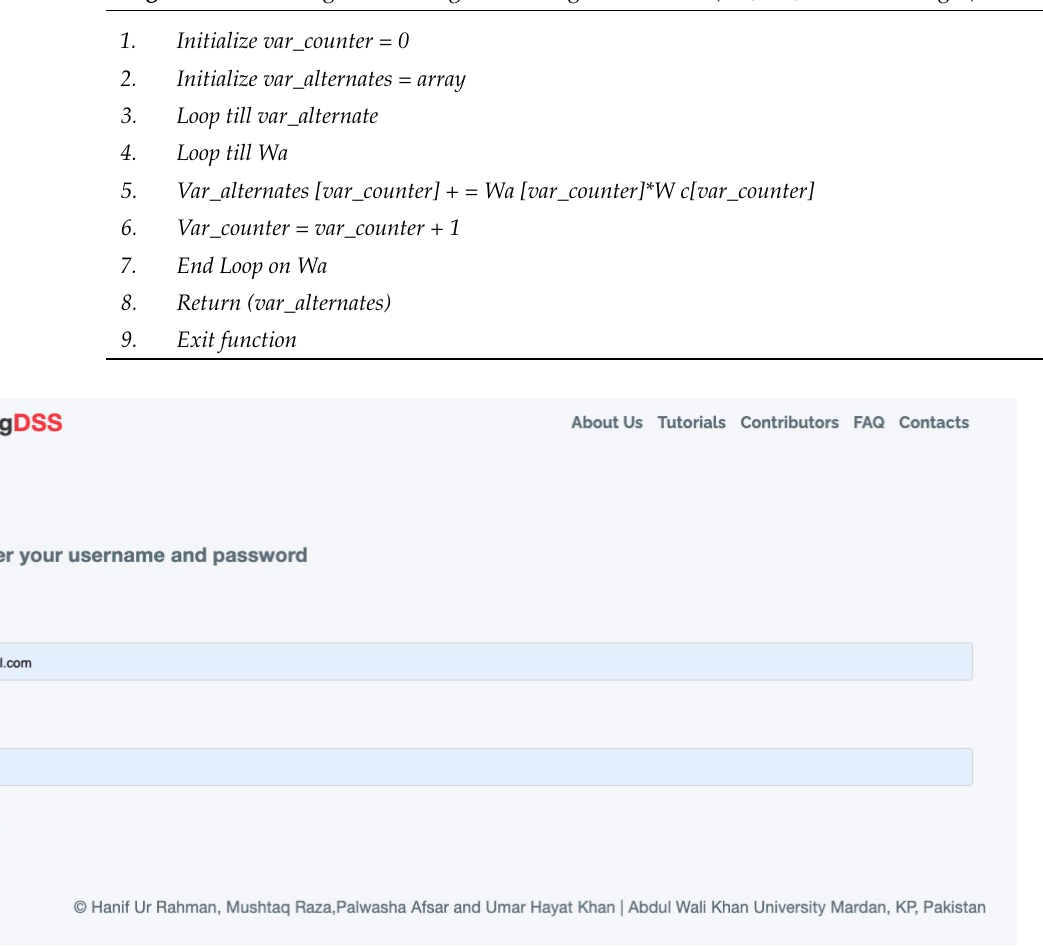
Table 5. Identifying the ranking of sourcing alternatives. Algorithm 3: Finding the Ranking of Sourcing Alternatives (Wa, Wc, AlternateLength)